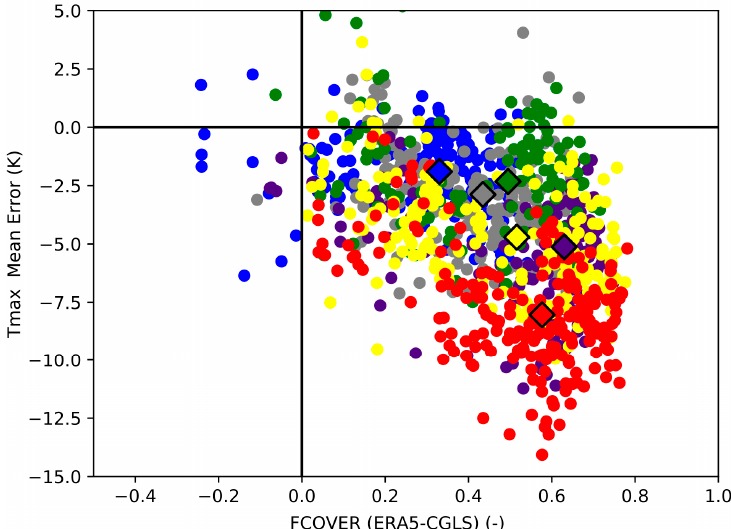
Figure 6. Tmax Mean Error (K) in ERA5 as function of the difference between CGLS ‐ FCover and ERA5 Total Vegetation Cover (TVC). The colors represent the clusters in Figure 2. The diamond marker represents the median value of each